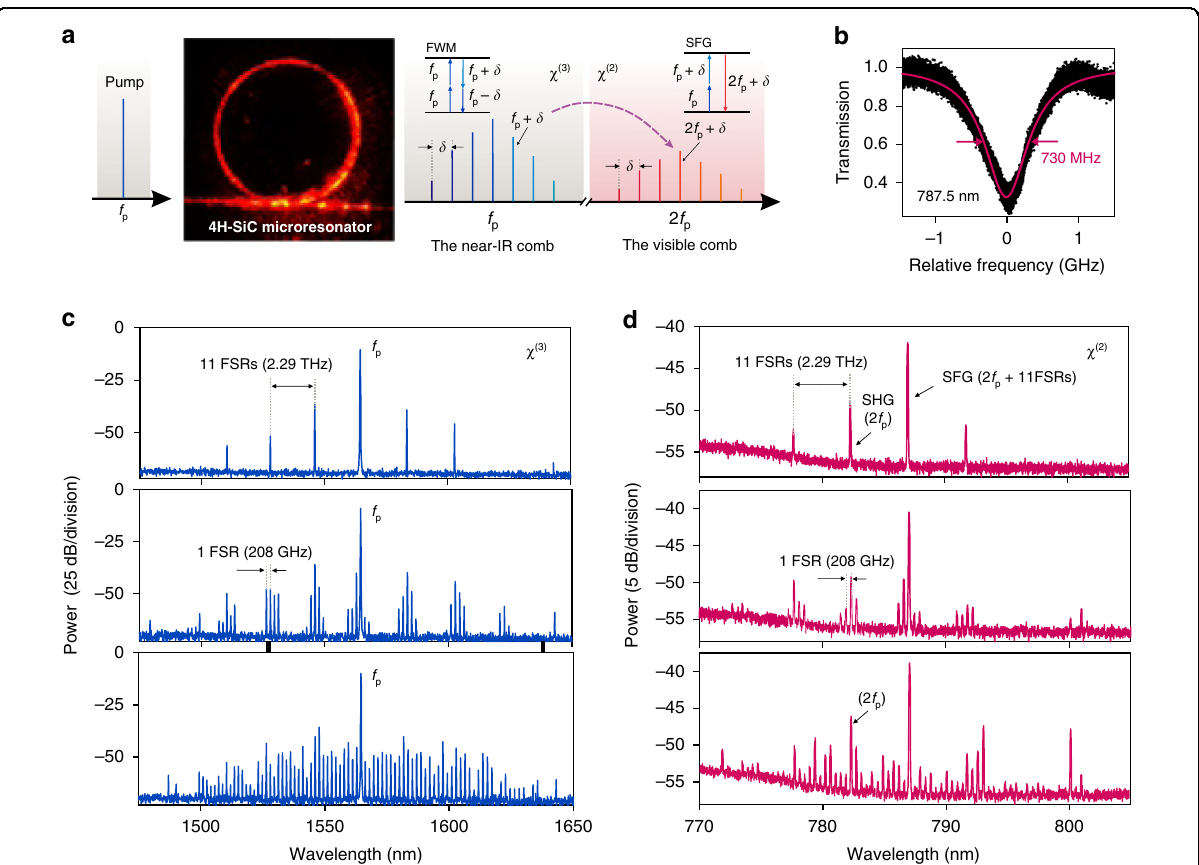
Fig. 5 Comb spectral translation from near-IR to visible. a Schematic of the comb spectral translation through second- and third-order nonlinearities in the 4H-SiC microresonator. FWM four-wave mixing, SFG sum-frequency generation. The optical image shows the frequency-doubled pump scattered from the microresonator. b A resonance pro fi le at 787.5 nm with a Lorentzian fi t showing a linewidth of 730 MHz, corresponding to loaded Q factor of 5.26 × 10 5 . c , d Optical spectra of the near-IR and visible combs with different frequency